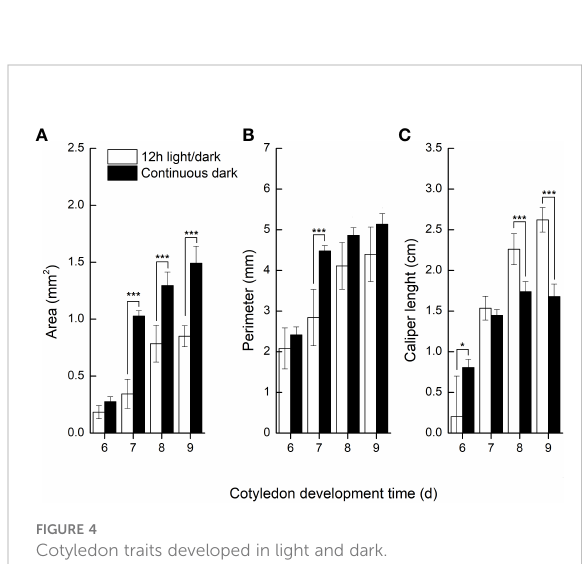
FIGURE 4 Cotyledon traits developed in light and